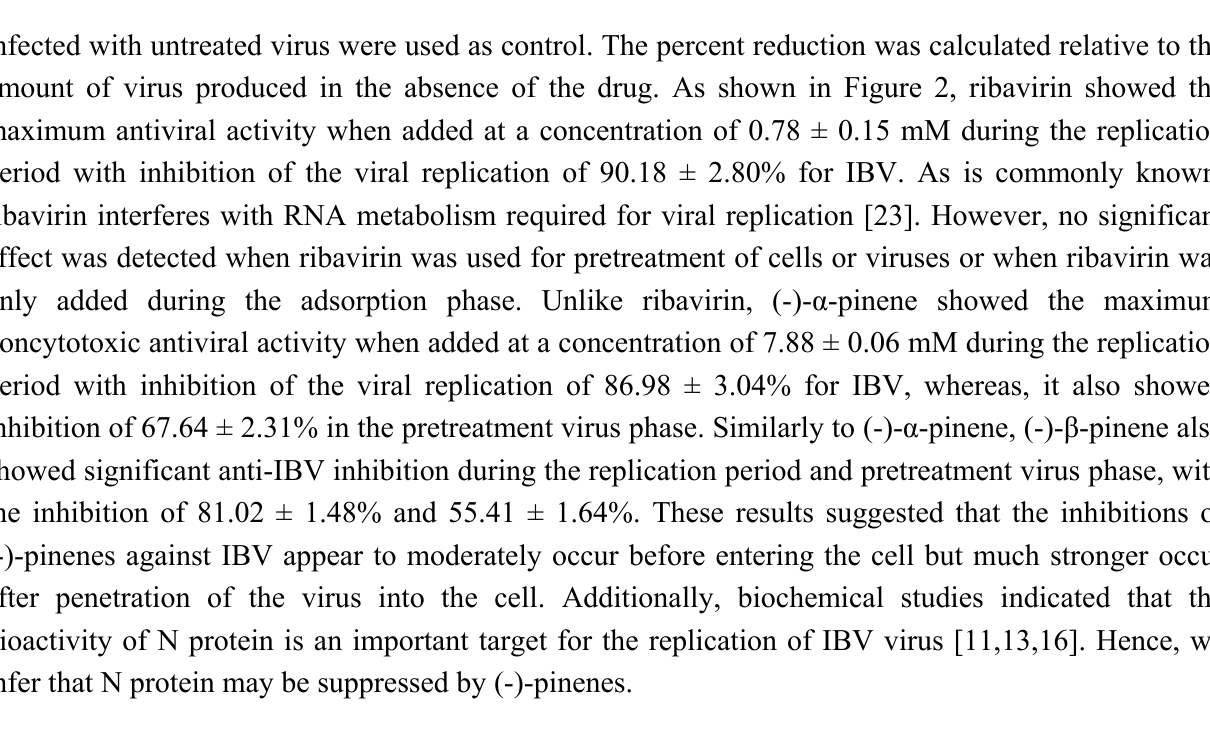
Figure 2. Antiviral effects of (-)- α -pinene (7.88 mM), (-)- β -pinene (6.09 mM) and ribavirin (0.78 mM) against IBV by incubation at different periods of time during infection.